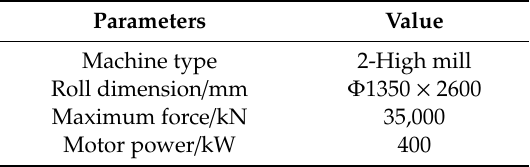
Table 2. Main parameters of heavy reduction rolling mill.